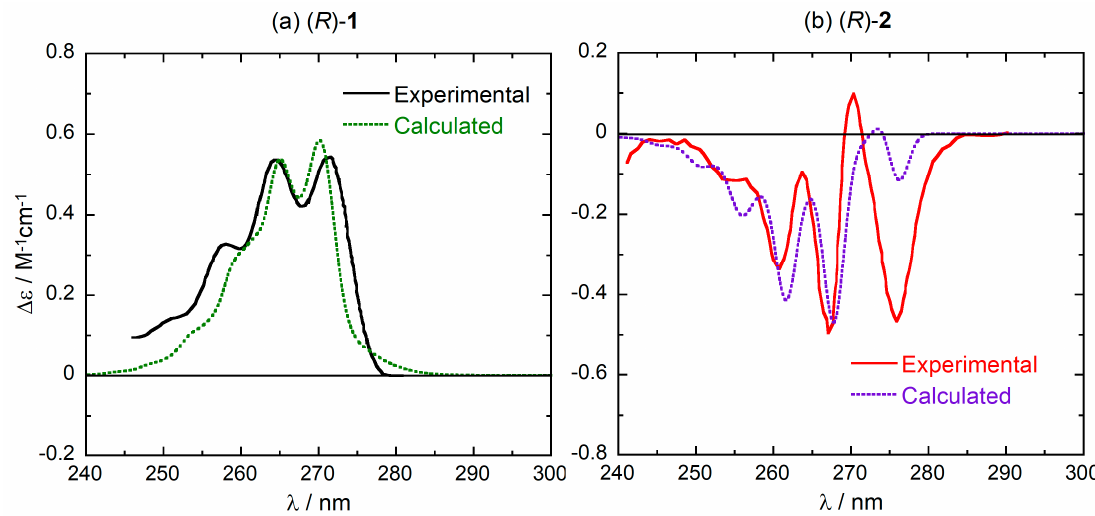
Figure 4. Comparison between the experimental and weighted-average calculated vibronic ECD spectra of ( R )- 1 (panel a ) and ( R )- 2 (panel b ) in the 1 L b region. Calculated spectra plotted as sums of Gaussians with 0.025 eV exponential band-width, shifted by +30 nm and scaled by a factor 5 for better comparison. Experimental spectra reproduced from Ref. [28] with permission of Taylor & Francis Ltd., www.tandfonline.com.